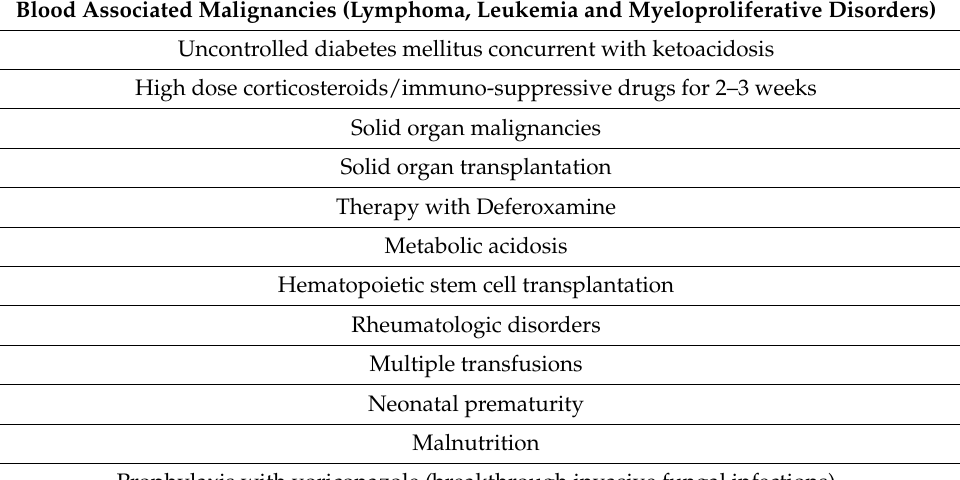
Table 1. Critical predisposing factors which increase mucormycosis vulnerability. Blood Associated Malignancies (Lymphoma, Leukemia and Myeloproliferative Disorders) Uncontrolled diabetes mellitus concurrent with ketoacidosis High dose corticosteroids/immuno-suppressive drugs for 2–3 weeks Solid organ malignancies